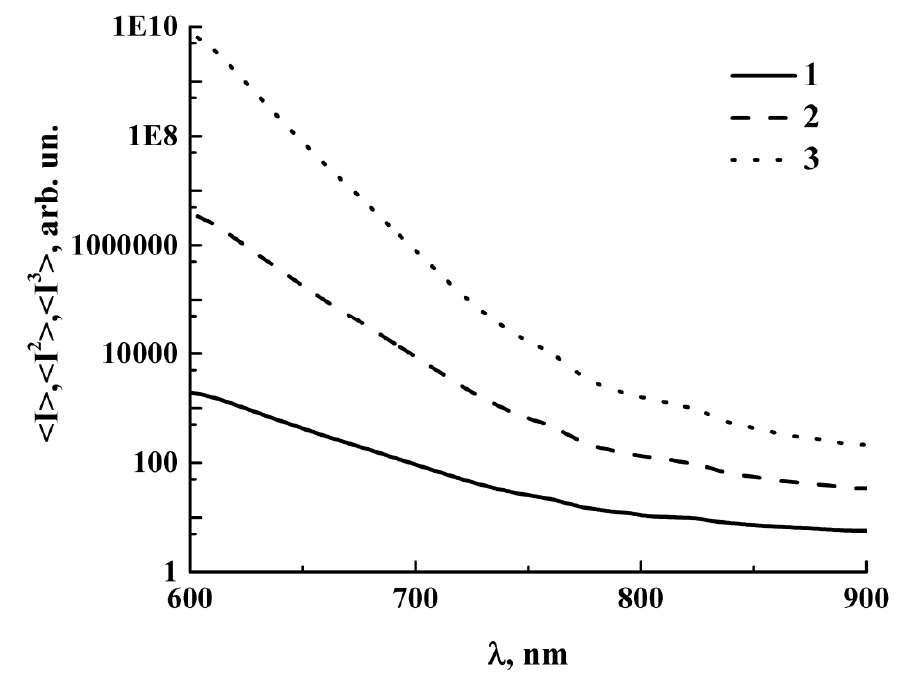
2 I 3 I ; 3— . (cid:68) (cid:69) (cid:68) (cid:69) I 2 I 3 ; 3— .